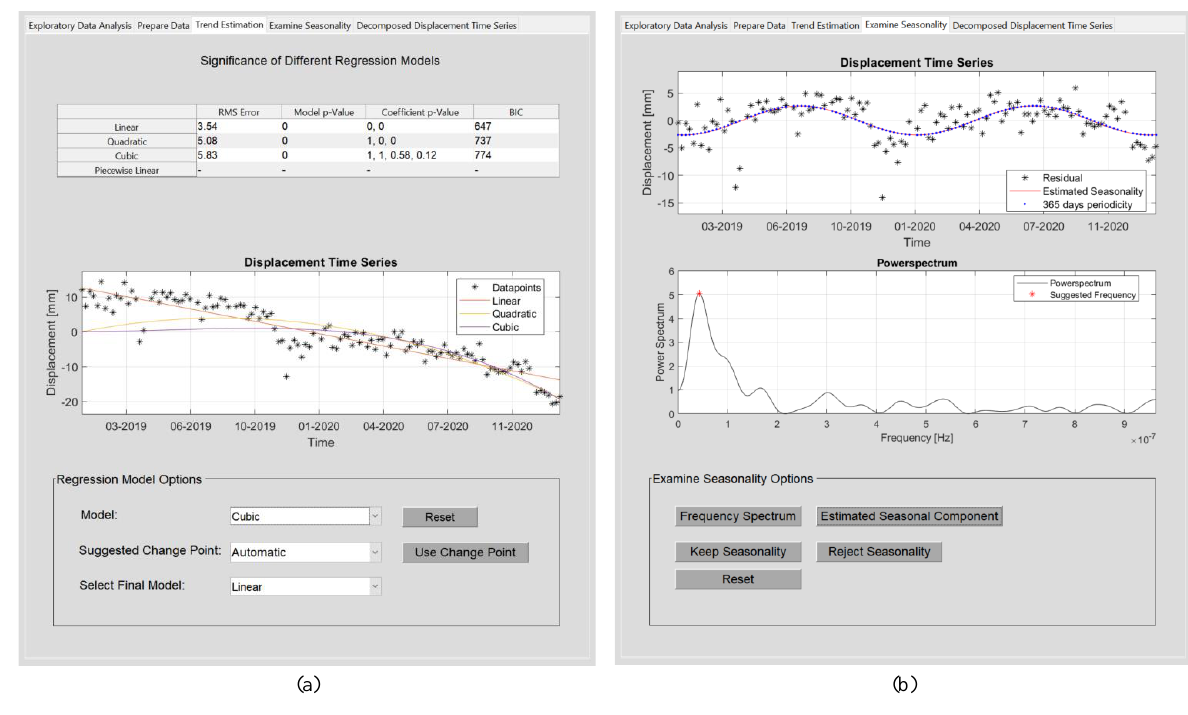
Figure 7 . EDA (a) and outlier detection (b) of the time series of PS 1.